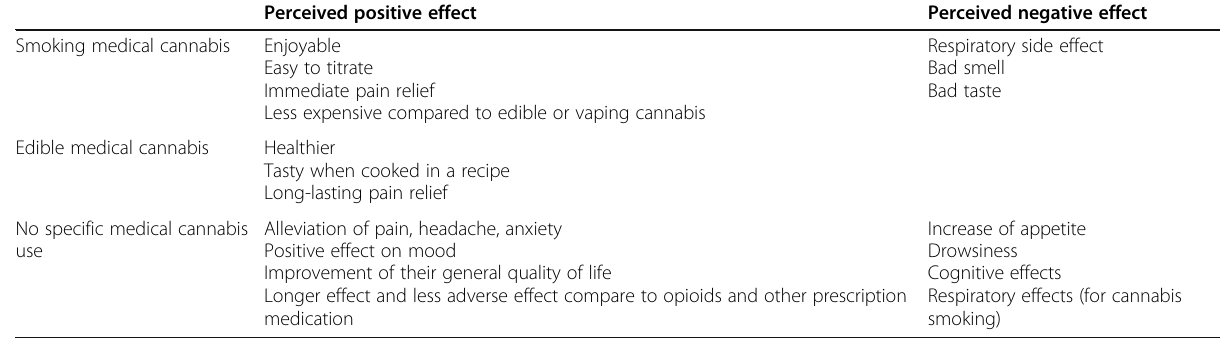
Table 3 Perceived positive and negative effects